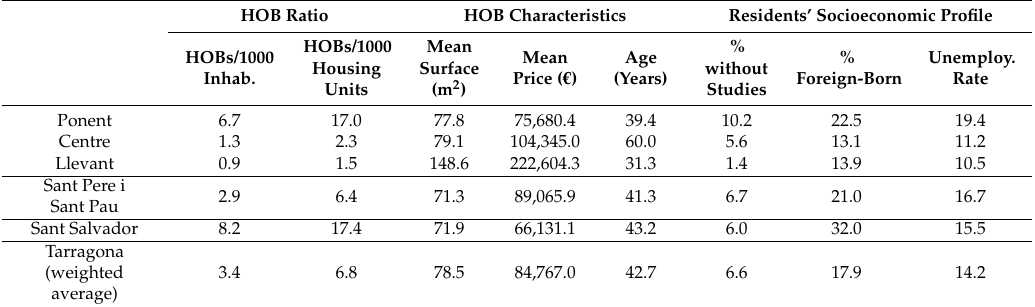
Table 3. HOB (housing units owned by banks) distribution by neighborhood according to their characteristics and socioeconomic profiles (Tarragona).